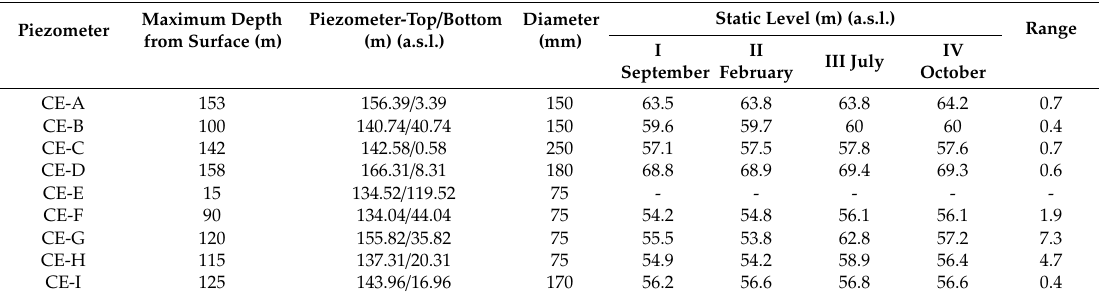
Table 1. Maximum depth, piezometer-top / bottom and diameter, and static water level of the CE-A, CE-B, CE-C, CE-D, CE-E, CE-F, CE-G, CE-H, and CE-I piezometers in the four sampling campaigns (I, II, III and IV). Static level was not measured for CE-E piezometer. a.s.l. = above sea